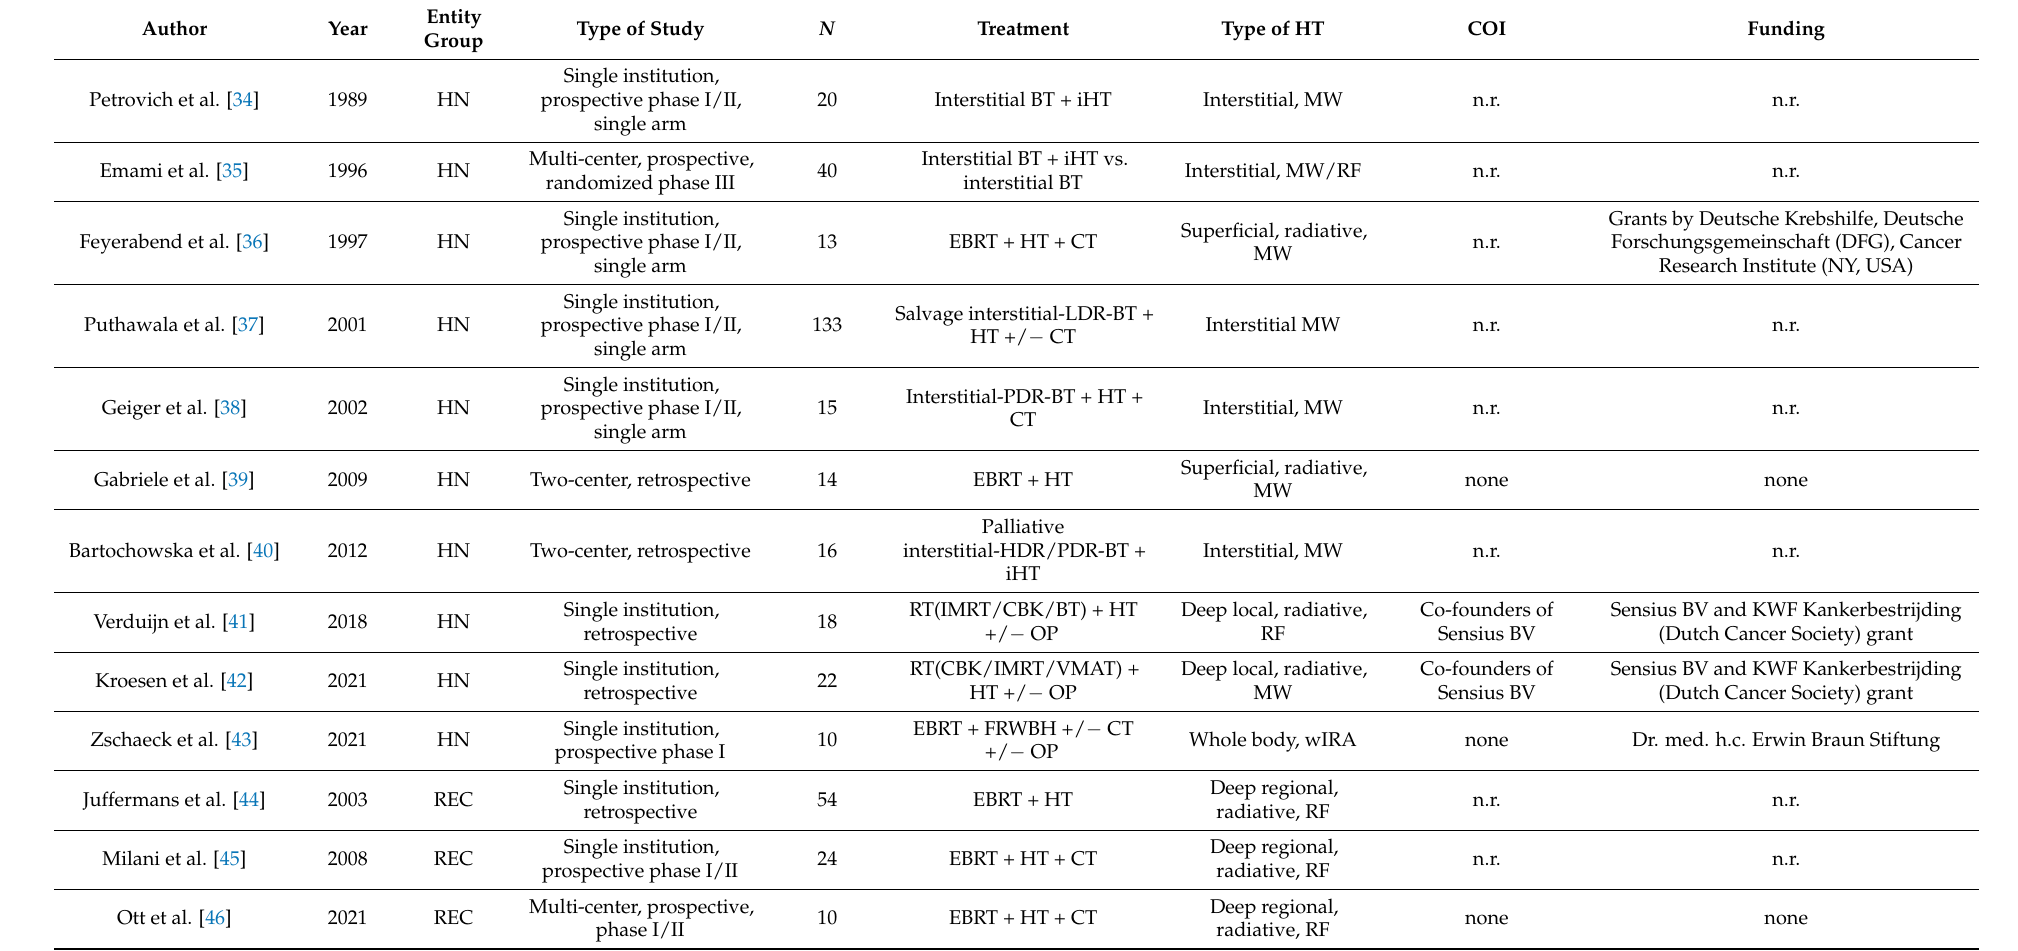
Table 1. Overview of included studies for combined re-irradiation and hyperthermia